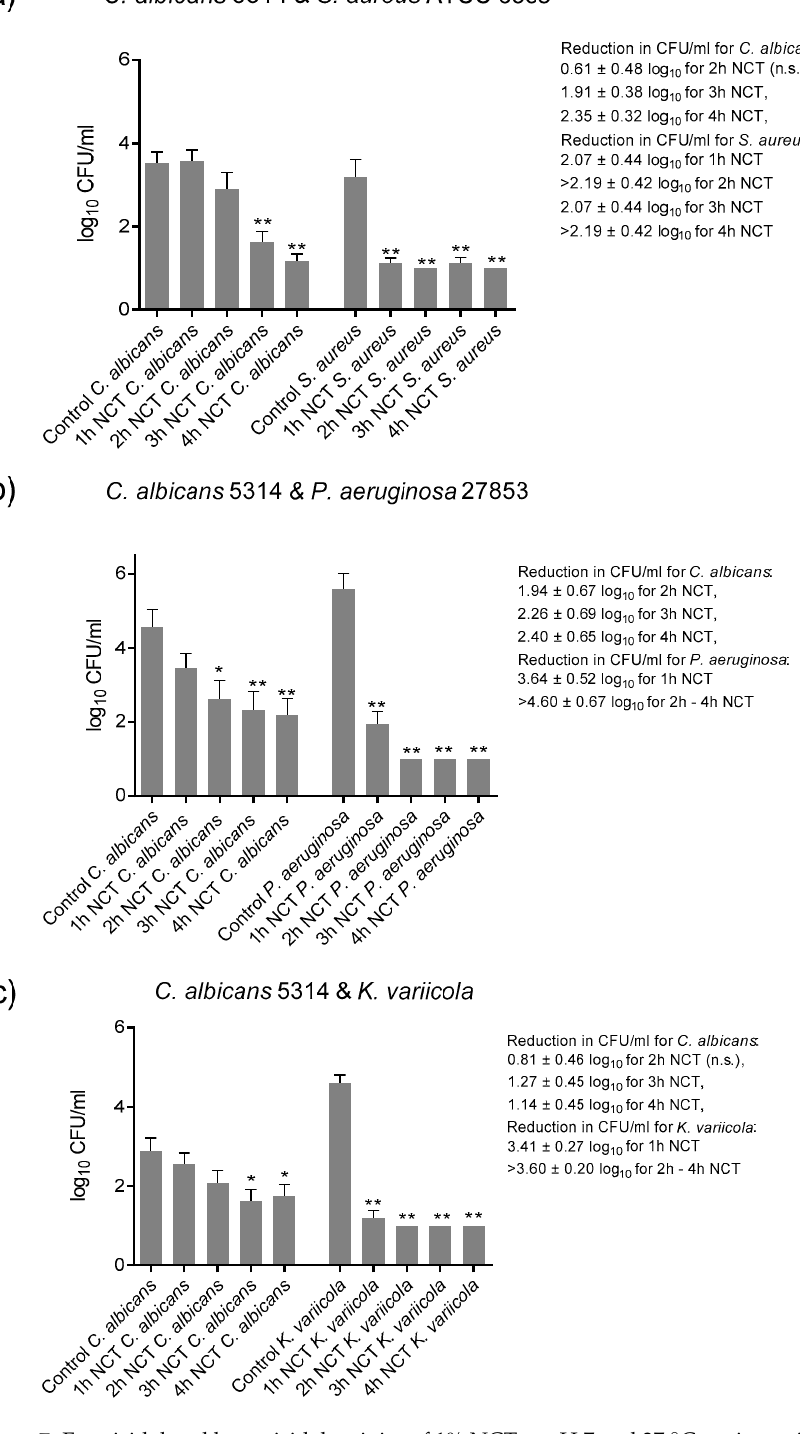
Figure 7. Fungicidal and bactericidal activity of 1% NCT at pH 7 and 37 ◦ C against mixed biofilms of C. albicans ATCC 5314 plus S. aureus ATCC 6538 ( a ), P. aeruginosa ATCC 27853 ( b ) or K. variicola ( c ) clinical isolate grown for 5 ( S. aureus ) to 7 weeks. Weekly evaluation by quantitative killing assays. Summary of all values of NCT and controls. Mean values ± SEM, n = 15–17 ( S. aureus ), 10–15 ( P. aeruginosa ), and 18–20 ( K. variicola ) values each from 3–5 independent experiments; * p < 0.05 versus control; ** p < 0.01 versus control; n.s.: not